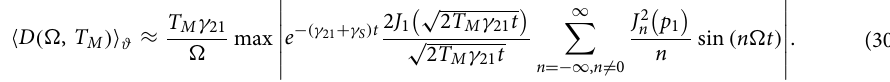
( 2 �) . For the case plotted in Fig. 5 and for